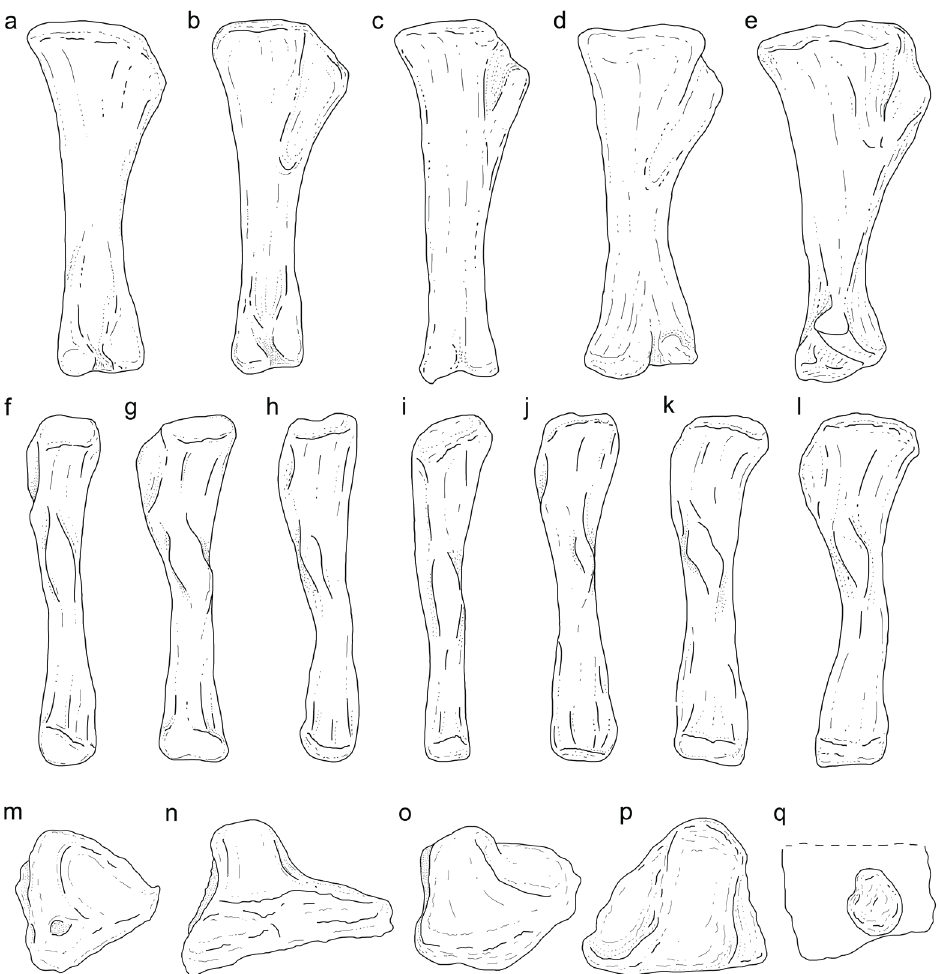
Figure 8 – Morphological comparison of titanosaurian tibiae ( a - e ), fibulae ( f - l ), and tarsals ( m - q ). South American taxa denoted with an asterisk. ( a)-(e ), right tibiae in lateral view: ( a ) Mendozasaurus neguyelap *, IANIGLA-PV 073/2, redrawn from González riga et al. (2018), ( b ) Laplatasaurus araukanicus *, MLP-CS 1128, redrawn from Gallina and Otero (2015), ( c ) Epachthosaurus sciuttoi *, UNPSJB-PV 920, redrawn from Martínez et al. (2004), ( d ) Dreadnoughtus schrani *, MPM-PV 1156, redrawn from Ullmann and Lacovara (2016), ( e ) Saltasaurus loricatus *, PVL 4017-84, redrawn from Powell (1992). ( f )-( l ), left fibulae in lateral view: ( f ) Laplatasaurus araukanicus * (reversed), MLP-CS 1127, redrawn from Gallina and Otero (2015), ( g ) Uberabatitan ribeiroi *, CPP-1107-Urho, redrawn from Salgado and de Souza Carvalho (2008), ( h ) Epachthosaurus sciuttoi *, UNPSJB-PV 920, redrawn from Martínez et al. (2004), ( i ) Rapetosaurus krausei (reversed), FMNh Pr 2209, redrawn from Curry rogers (2009), ( j ) Mendozasaurus neguyelap *, IANIGLA-PV 074/3, redrawn from González riga (2003), ( k ) ‘ Neuquensaurus robustus ’*, MLP-CS 1265, redrawn from Otero (2010), ( l ) Dreadnoughtus schrani *, MPM-PV 1156, redrawn from Ullmann and Lacovara (2016). ( m )-( q ), tarsal elements in various views: ( m ) left astragalus in proximal view of Dreadnoughtus schrani *, MPM-PV 1156, redrawn from Ullmann and Lacovara (2016), ( n ) right astragalus in anterior view of Notocolossus gonzalezparejasi *, UNCUYO-LD 302, redrawn from González riga et al. (2016), ( o ) right astragalus in anterior view of Elaltitan lilloi *, PVL 4628, redrawn from Mannion and Otero (2012), ( p ) left astragalus in anterior view of Uberabatitan ribeiroi *, CPP-1082-Urho, redrawn from Salgado and de Souza Carvalho (2008), ( q ) calcaneum adhered to medial surface of distal fibula of Elaltitan lilloi *, PVL 4628, redrawn from Mannion and Otero (2012). Not to